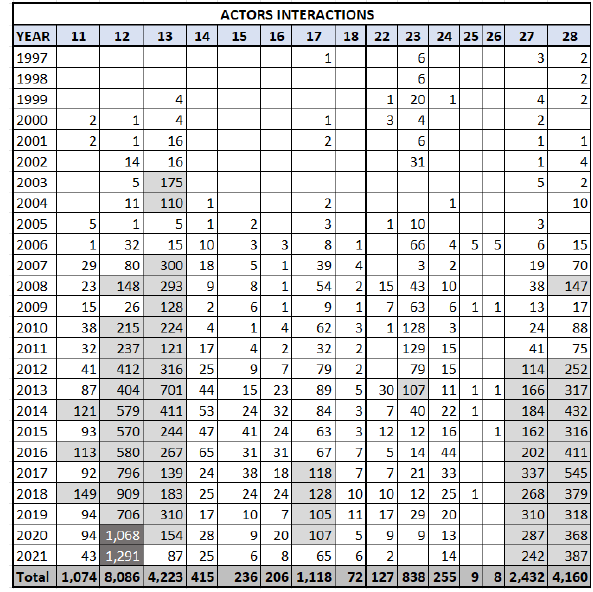
Table 3. A number of Actors Interactions by